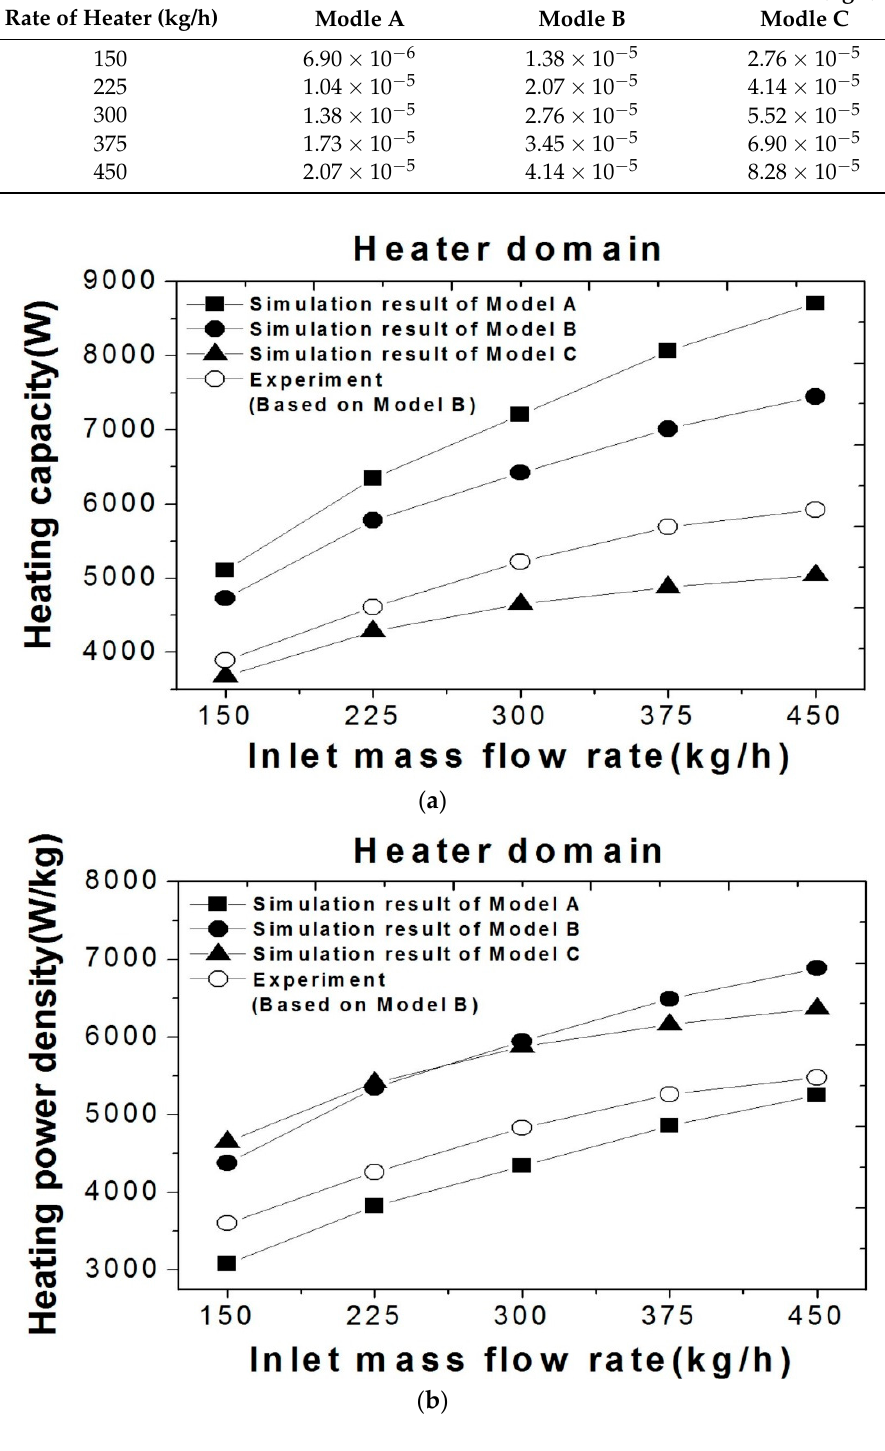
Figure 9. Variation of inlet air mass flow rate, ( a ) heater heating capacity, ( b ) heater power density.